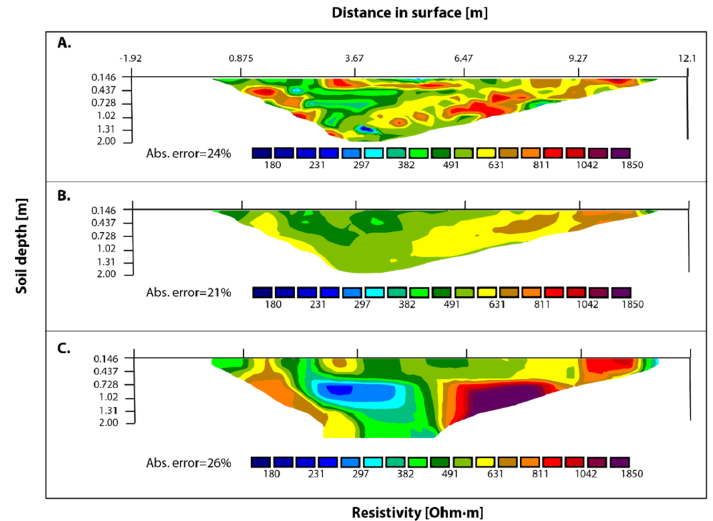
Figure 6. Inverse model resistivity section plots of farms in Santander. ( A ) El Carmen de Chucur í (1813 Ohm · m); ( B ) Rionegro (1729 Ohm · m); and ( C ) San Vicente de Chucur í (1837 Ohm · m). The closely related cadmium compounds are highlighted in red / violet colors ranging from 1002–1837 Ohm ·